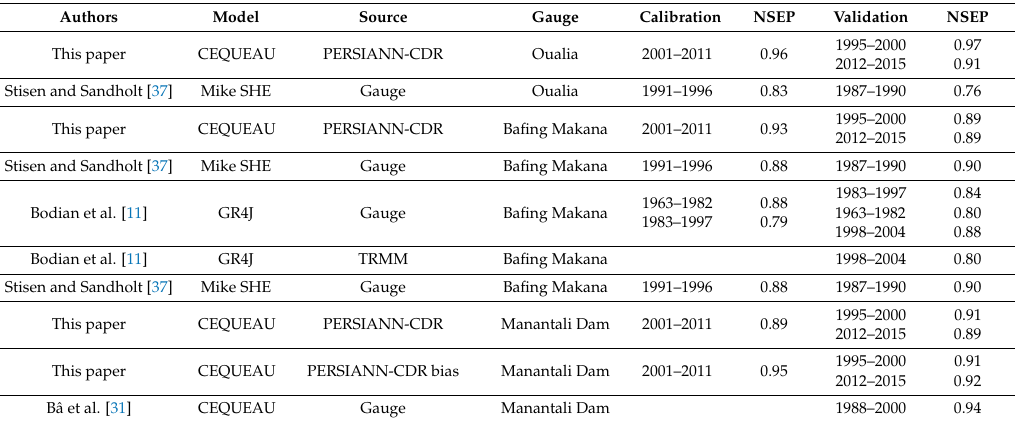
Table 9. Comparison with other studies over the Senegal